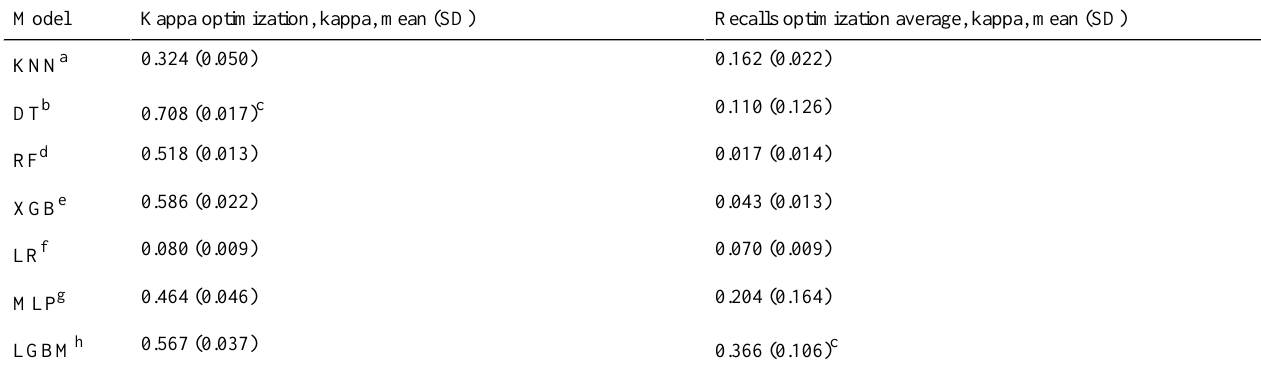
Table 4. Predictability of respiratory needs per predictive